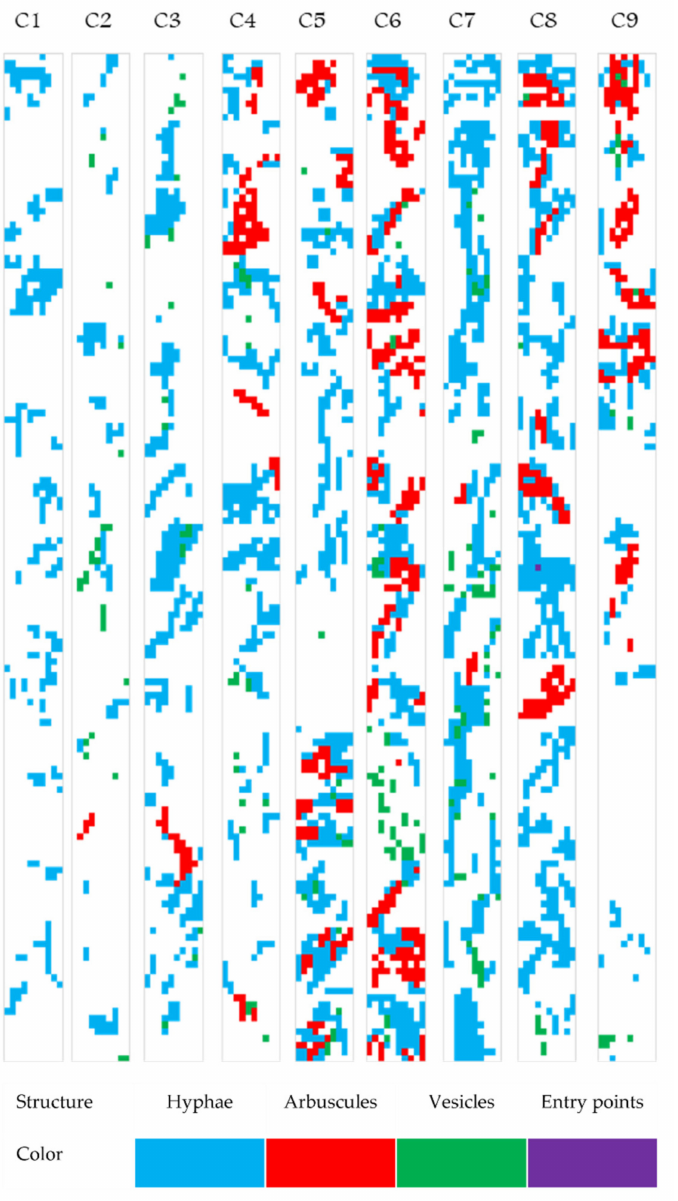
Figure 6. Native mycorrhizal patterns in the roots of Festuca rubra . Based on the MycoPatt color code, each structure and the area where it is present are coded by one single color: hyphae (blue), arbuscules (red), vesicles (green), and entry points (purple). C1–C9 represent the specific mycorrhizal map for each cluster described in Figure 5 and Table